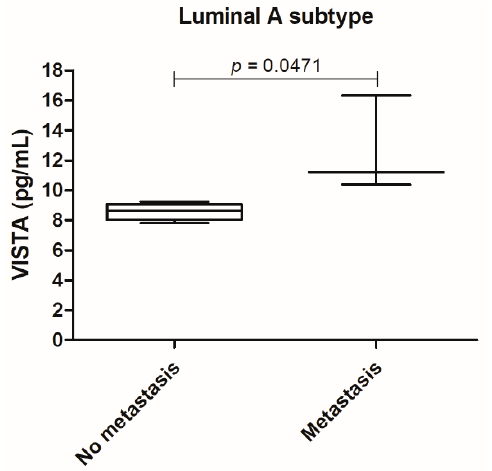
Figure 2. In the luminal A tumor subtype serum VISTA levels were higher in cats presenting metastasis (* p = 0.0471).